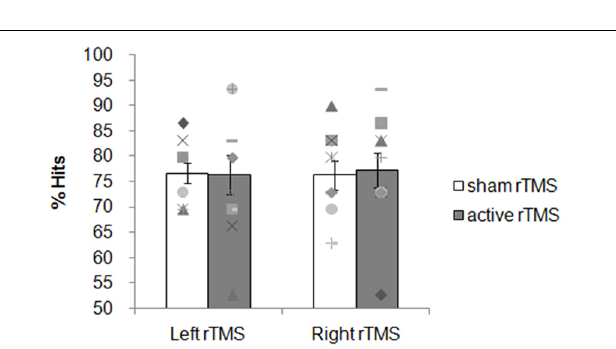
FIGURE 3 | Experiment 1: 1 Hz rTMS of the PCC before the encoding phase. Mean percentage of subjects’ correct responses and individual performances. Each symbol represents one participant; bar plots represent the average over participants, and error bars indicate standard